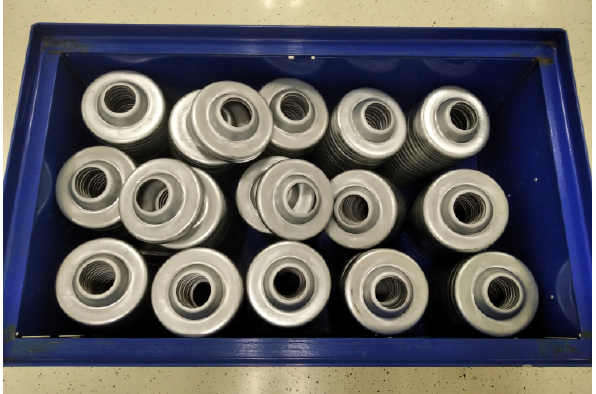
Figure 1. Distribution of parts in the transportation container.